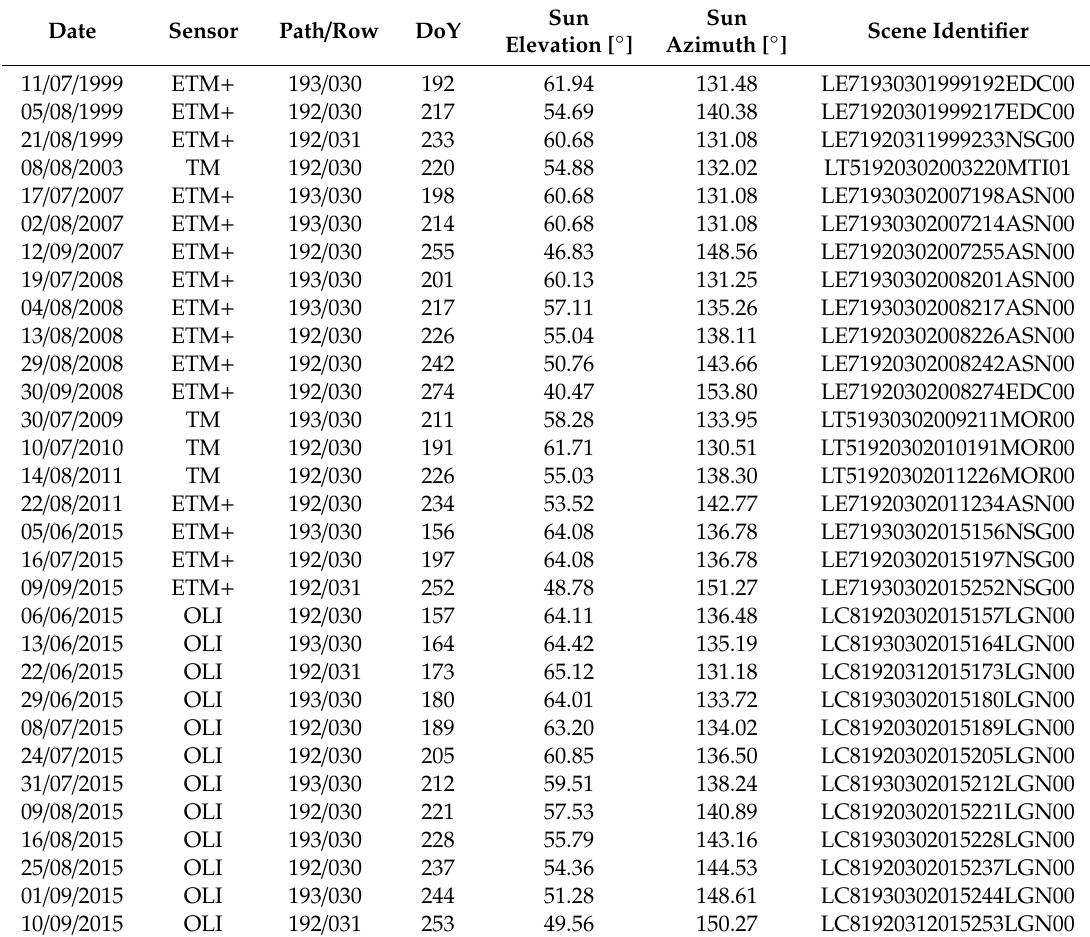
Description of the multi-temporal data from Landsat-5 Thematic Mapper (TM), Landsat-7 Enhanced Thematic Mapper (ETM + ), and Landsat-8 Operational Land Imager (OLI) used in this